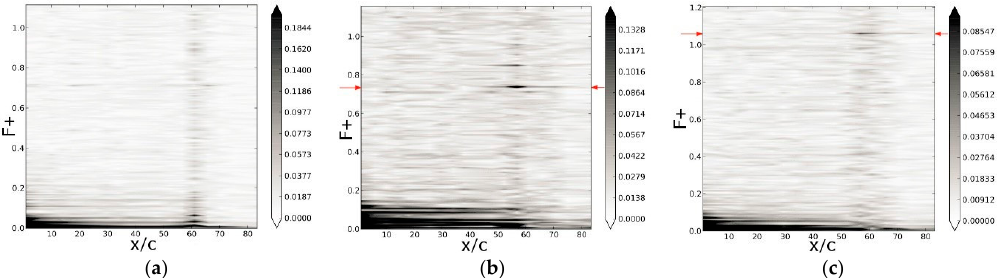
Figure 42. Free-flight measurements for Re = 390,000 and α = 0.3 degrees. Wall pressure coefficient spectra. ( a ) Uncontrolled, ( b ) control with F + = 0.75 and B = 0.05, and ( c ) control with F + = 1.05 and B = 0.05 (Reprinted by permission of the American Institute of Aeronautics and Astronautics, Inc. (Reston, VA, USA) from [37]).